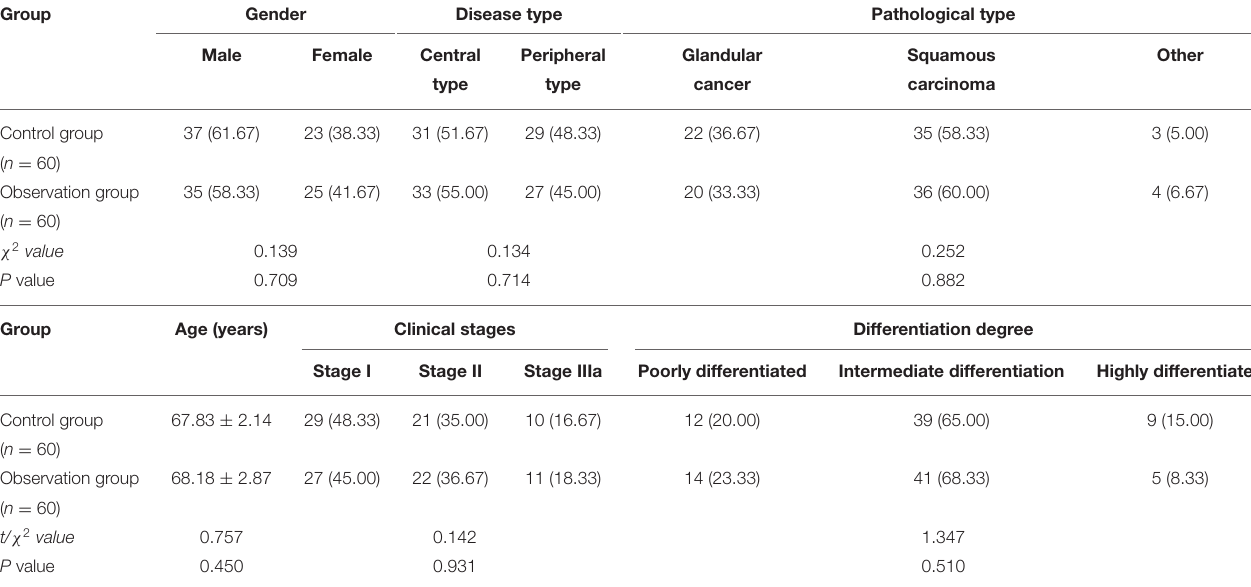
TABLE 1 | Comparison of general data of patients between the two groups ( n , x ± s).